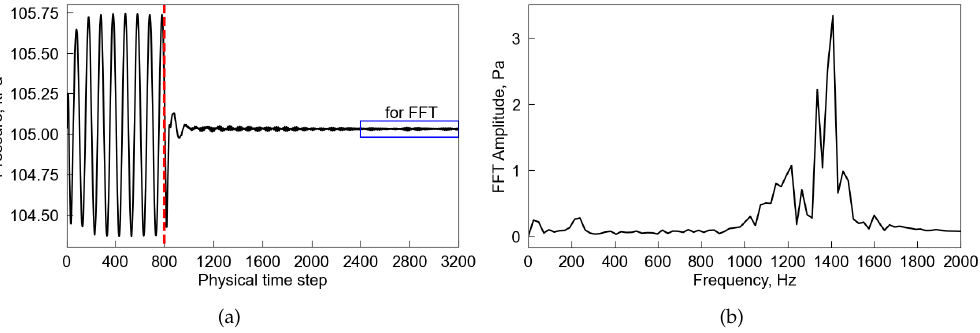
Figure 11. Unsteady pressure at the middle blade tip gap near the leading edge. ( a ) Time history. ( b ) Spectrum